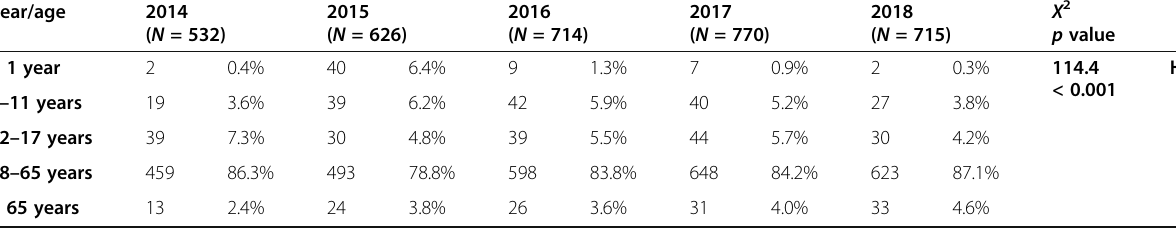
Table 1 Distribution of cases according to age group during the period of the